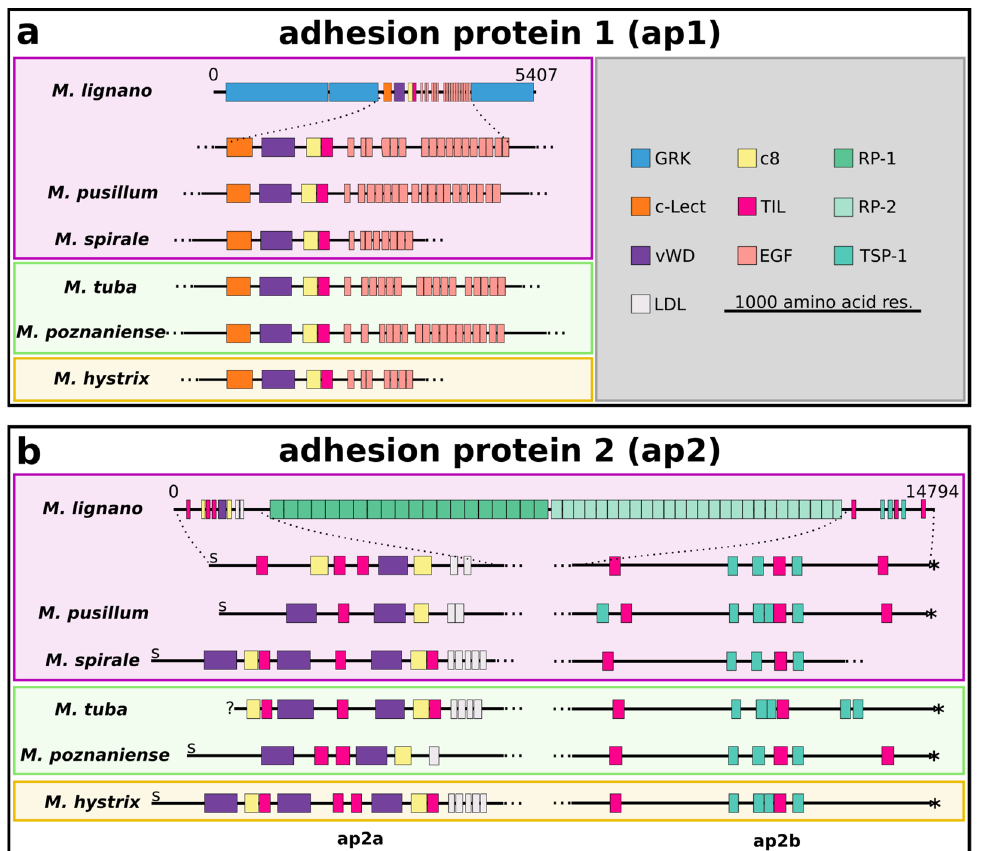
Figure 3. Protein domain architecture of ap1- and ap2-like adhesive proteins. Protein domain structure of Mlig-ap1-like ( a ) and Mlig-ap2-like ( b ) proteins in six Macrostomum species. C8, domain of eight conserved cysteines; c-Lect, c-type lectin domain; EGF, epidermal growth factor-like domain; GRK, low complexity region containing a high amount of arginine, lysine, and glycine; LDL, low-density lipoprotein receptor-like domain; RP-1, repeat motif 1; RP-2, repeat motif 2; TIL, trypsin inhibitor-like domain; TSP-1, thrombospondin 1-like domain; vWD, von Willebrand factor type D-like domain. S in the N-terminal end represents a signal peptide. Marine species outlined in pink, brackish species outlined in yellow, freshwater species outlined in green. The asterisk in the C-terminal end represents a stop codon. Dotted lines indicate a non-shown protein region. The 5 ′ -end of Mtub-ap1 was probably not completely assembled and is marked by a question mark. The scale bar is true for the closed-up protein fragments and not the whole proteins of M. lignano.